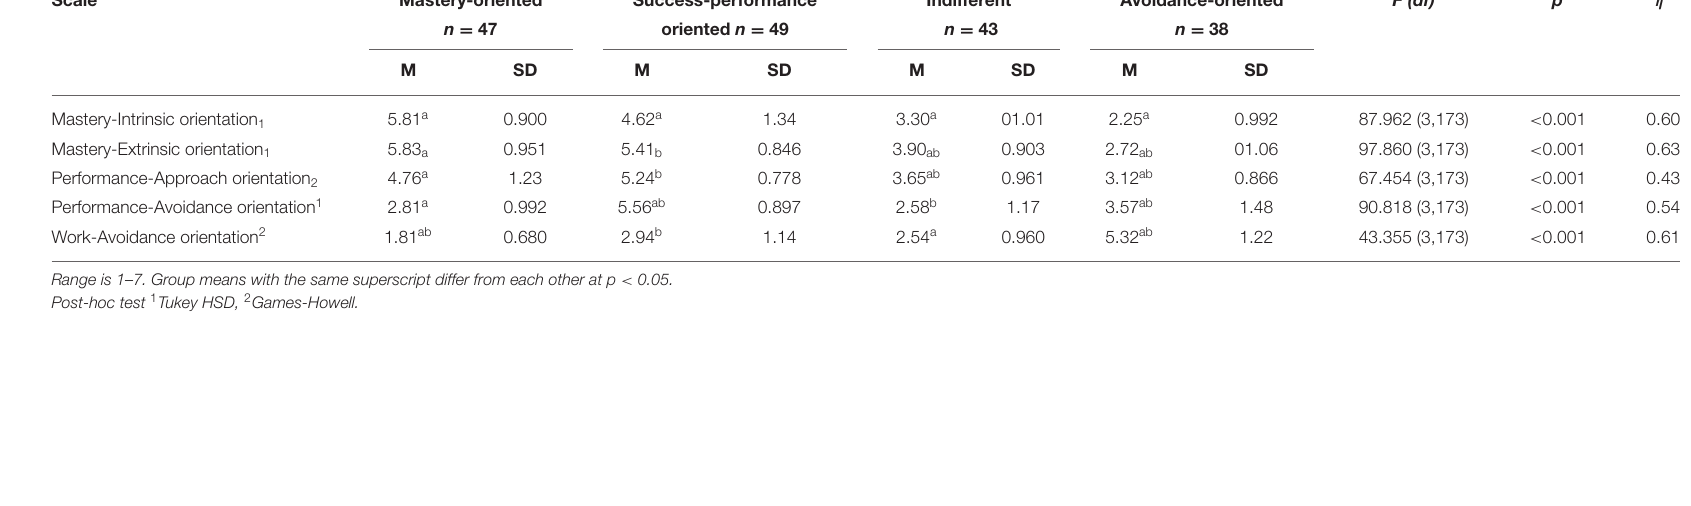
TABLE 3 | Mean differences on achievement goal orientations between goal-orientation groups. Scale